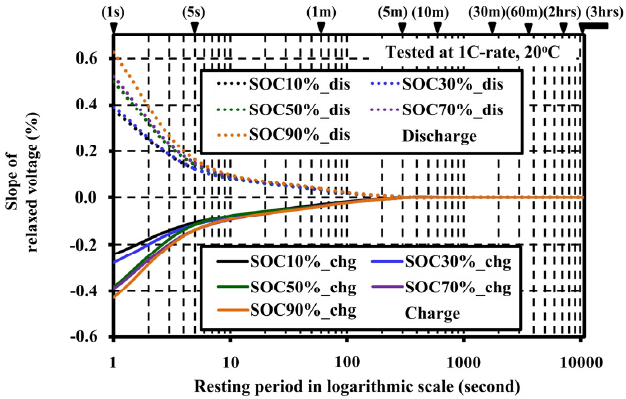
Figure 5. Slopes of the relaxed voltage versus the resting periods.